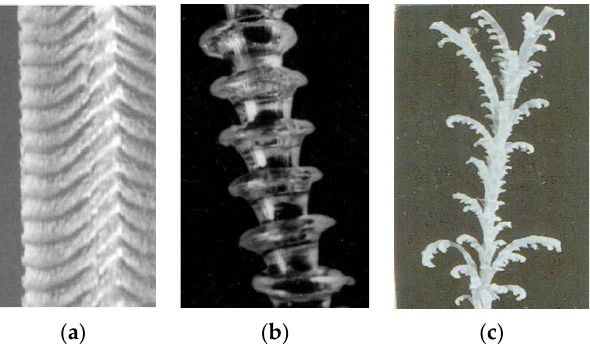
Figure 3. Different stages of elastic instability observed in increasing the Weissenberg number: ( a ) appearance of small- scale defects called “sharkskin”, ( b ) transition to strong periodic distortions, ( c ) developed elastic turbulence accompanied by melt fracture.